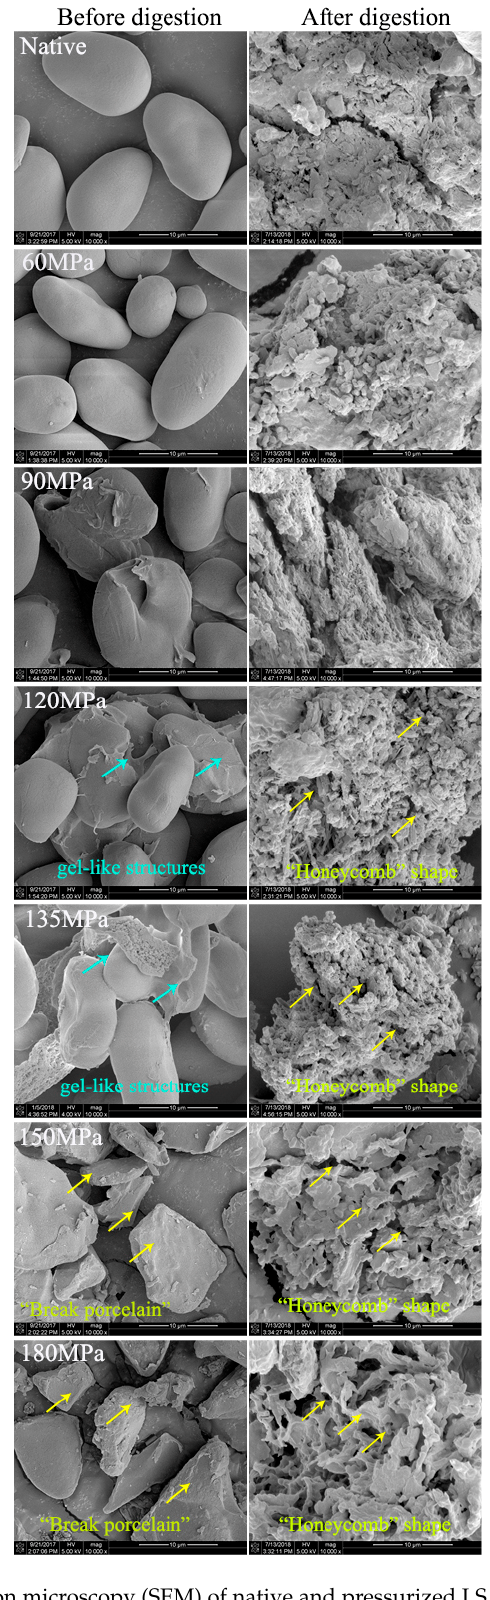
Figure 3. Scanning electron microscopy (SEM) of native and pressurized LS before digestion (10,000 × ) and after digestion (10,000 × ) in the DIVRSD (dynamic in vitro rat stomach system) model for 180